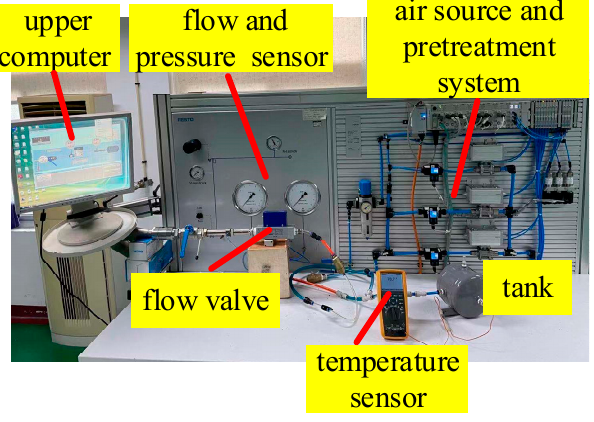
Figure 1. Field picture of the test device.